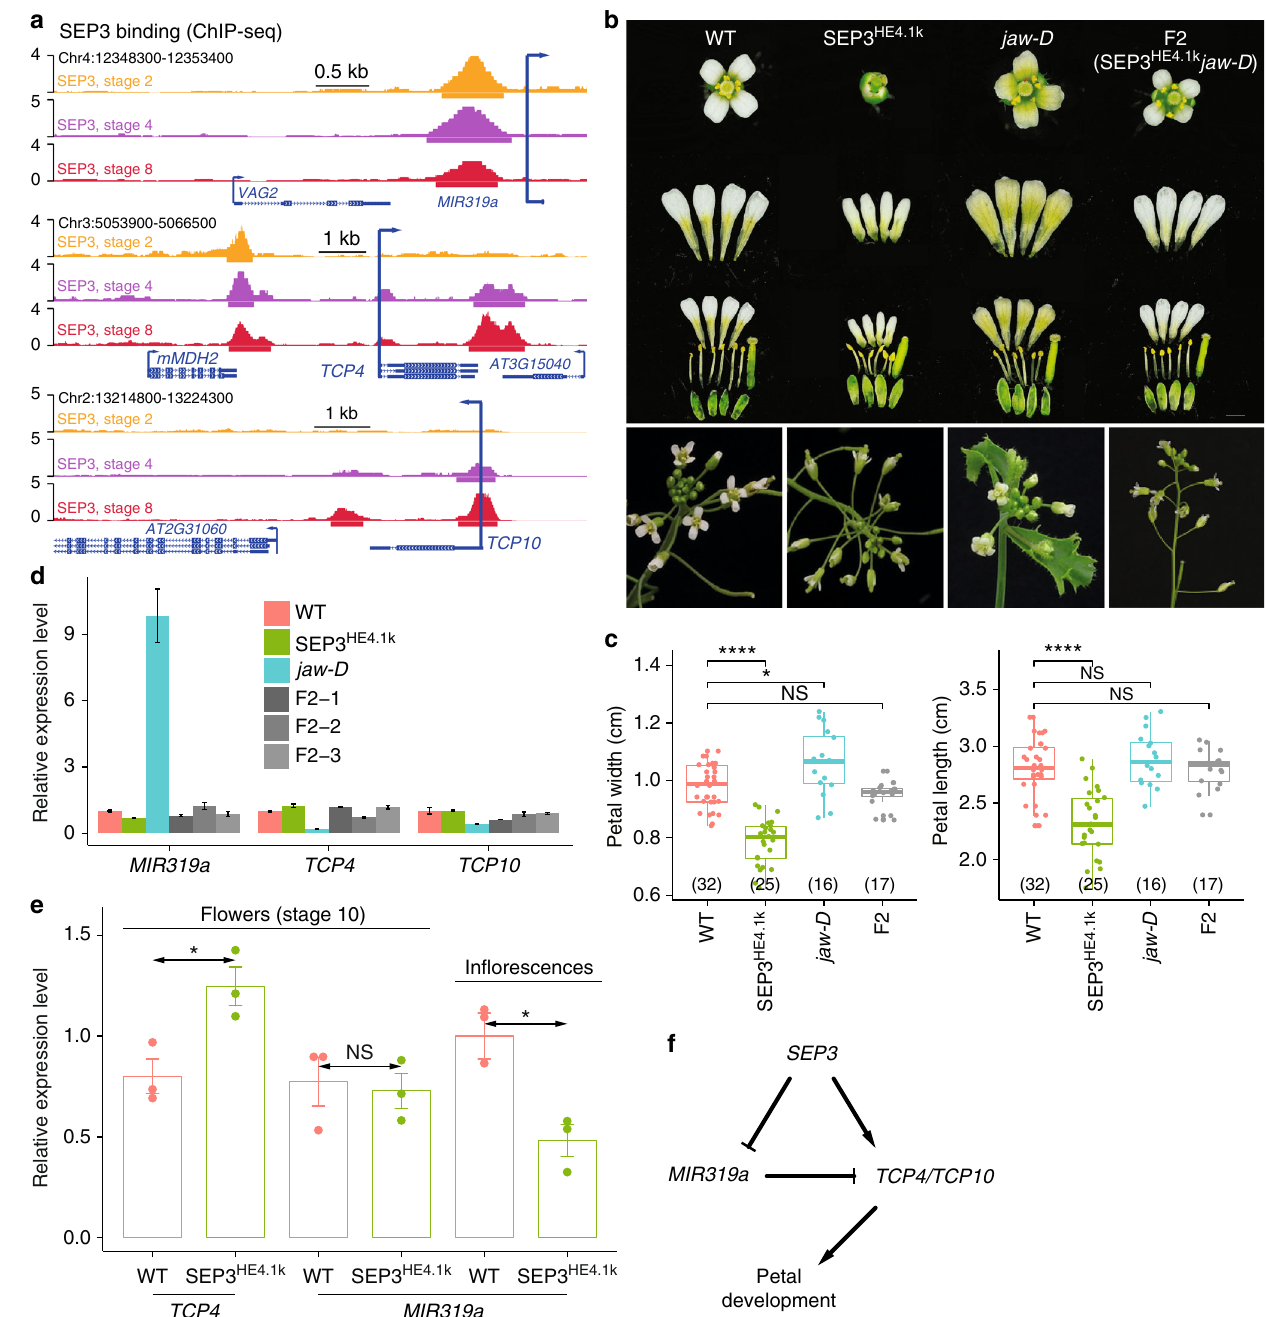
Fig. 4 SEP3 as a direct regulator of MIR319a . a Dynamics of SEP3 binding at the loci of MIR319a (top), TCP4 (middle), and TCP10 (bottom). Arrows indicate transcriptional directions. b Pictures of single fl owers and separated petals as well as other fl ower organs (top panel; scale bar = 1 mm) and in fl orescences (bottom) of wild-type (WT) plants, enhanced expression of SEP3 (SEP3 HE4.1k ), jaw-D mutant lines, and combination (F2) of jaw-D mutant and SEP3 HE4.1k . c Boxplots showing the petal width (left) and petal length (right) of different genotypes in b . The number of biologically independent plants is shown in parentheses. Boxes represent quartiles, center lines denote 50th percentile, and whiskers extend to most extreme values within 1.5× interquartile range (IQR). Signi fi cance codes, ****: P -value <0.0001, *: P -value <0.05, and NS: not signi fi cant, by two-sided Mann – Whitney tests. Bar = mean ± s.e. d Relative expression of MIR319a , TCP4, and TCP10 in the in fl orescences of WT, jaw-D mutant, SEP3 HE4.1k lines, and three independent F2 lines produced by crossing jaw-D and SEP3 HE4.1k lines. e Relative expression of TCP4 and MIR319a in either whole in fl orescences or stage 10-enriched fl ower tissues of WT and SEP3 enhanced expression lines. For all the expression analysis, data represent mean of three independent biological replicates. The Tip41 gene (AT4G34270) was used as reference. Signi fi cance codes as in c . f SEP3 - MIR319a - TCP4 / TCP10 coherent feed-forward loop in regulation of petal